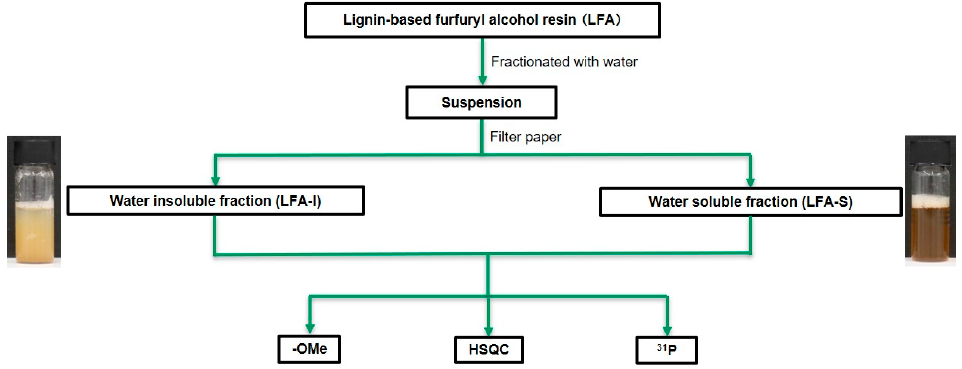
Figure 2. The scheme of fractionation of LFA resin for the structural analysis.